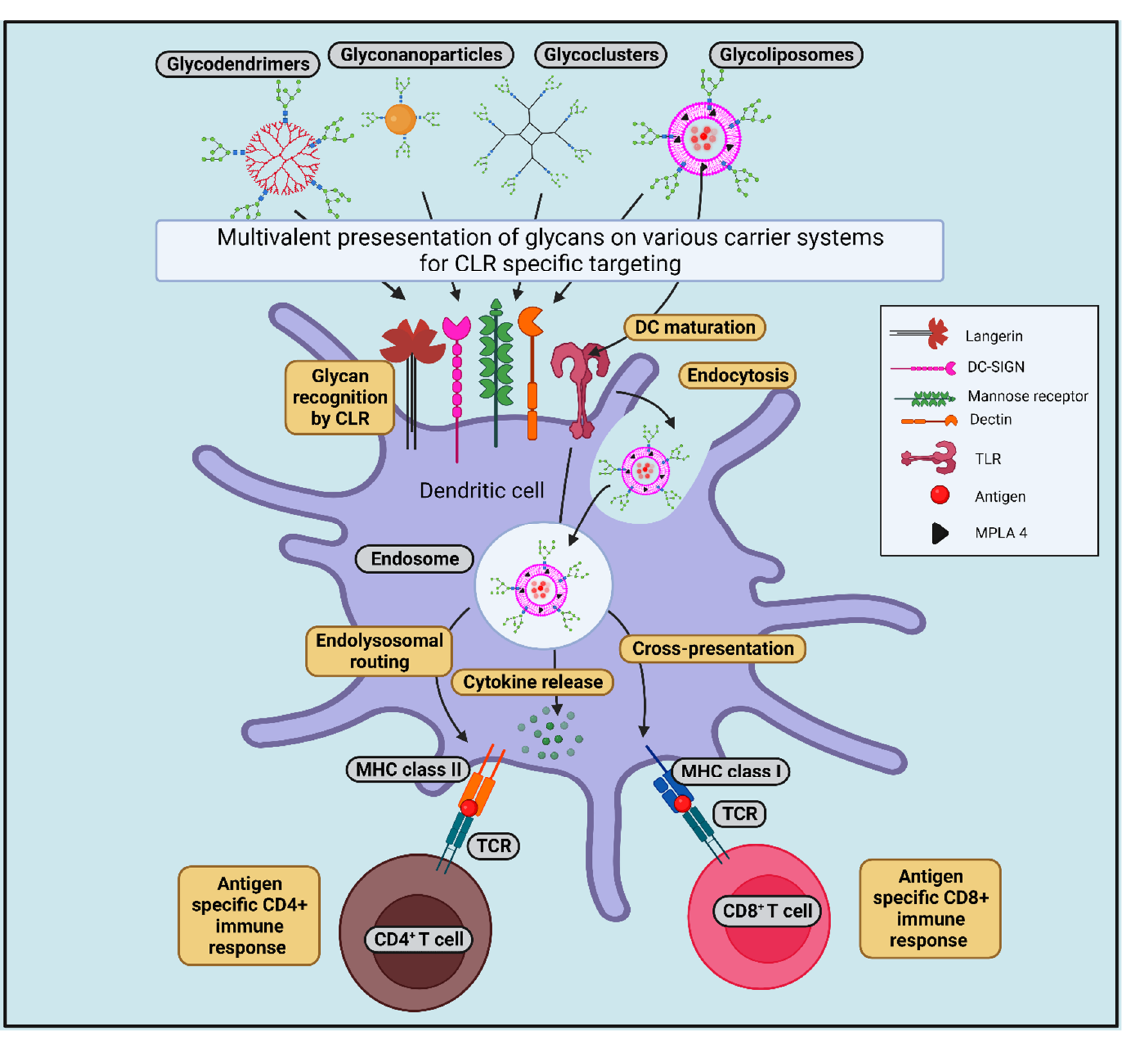
Figure 2. Multivalent presentation of glycans on various carrier systems for enhancing the antigen presentation to achieve effective T cell response. Glycan-modified nanocarriers present glycans in a multivalent form. Additionally, TLR ligands can also be incorporated with these glyconanocarriers. Glyconanocarriers, such as (i) glycoliposomes, which can be used for encapsulation of whole tumor antigens and adjuvants, (ii) glycodendrimers, which can be prepared with the desired number of glycans and peptides, and (iii) synthetic glycoclusters, which can also be prepared with tumor antigenic peptides. These glycan-modified nanocarrier systems loaded with tumor antigens are effectively internalized by DCs in a CLR-specific manner. The internalized antigens are presented by the MHC class I and II pathway for CD8 + and CD4 + T cell responses, respectively. The addition of MPLA, a ligand of TLR4 in glycoliposomes targeting CLR DC-SIGN, enhances DC maturation and cross-presentation of tumor antigens to CD8 + T cells (Created with BioRender.com accessed on 27 September 2022).